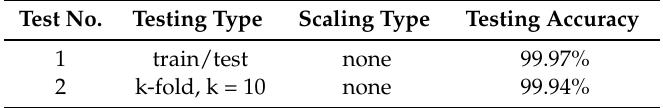
Table 10. Classification accuracy for M4 (Random Forests) on BUZZ1 train/test dataset. Test